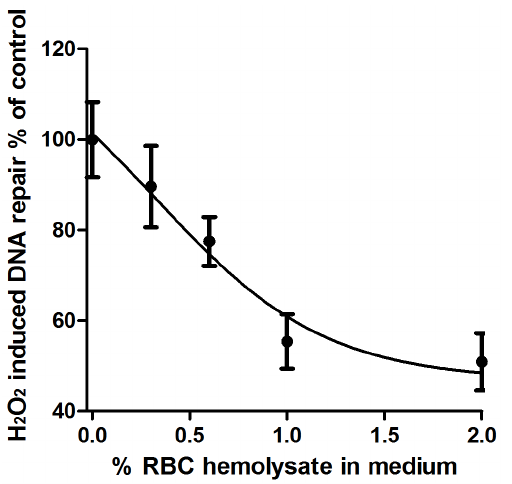
Figure 2. Dose-response curve of the effect of RBC hemolysate (% v / v in medium) on H 2 O 2 -induced DNA repair (% of control) in PBMC. For the effects of 0.3, 0.6, 1 and 2% v / v hemolysate, p=NS, p=NS, p , 0.005 and p , 0.005, respectively.